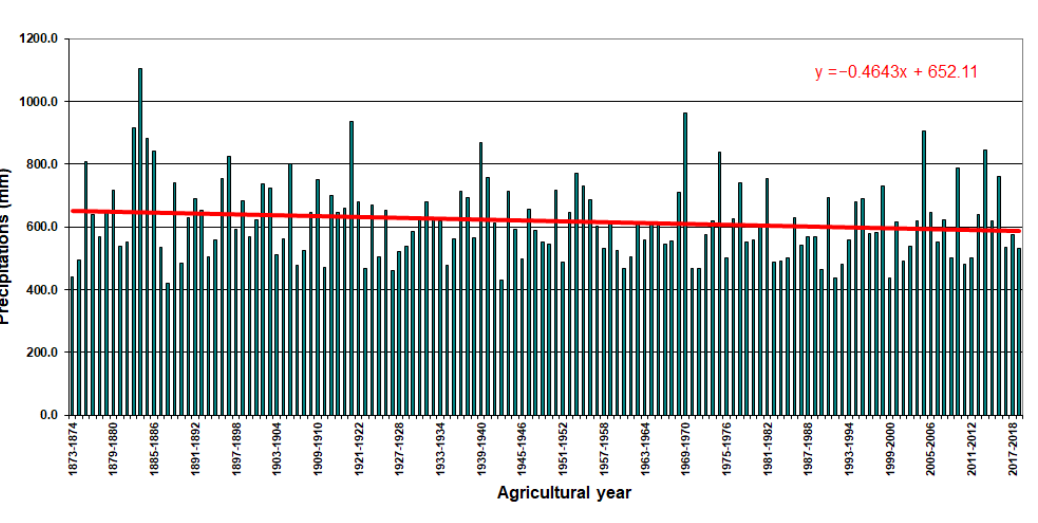
Figure 7. Evolution of the annual rainfall fallen in the Banat Plain, recorded at the Regional Meteorological Center Banat-Crisana over a period of 146 years (1873 – 2019).